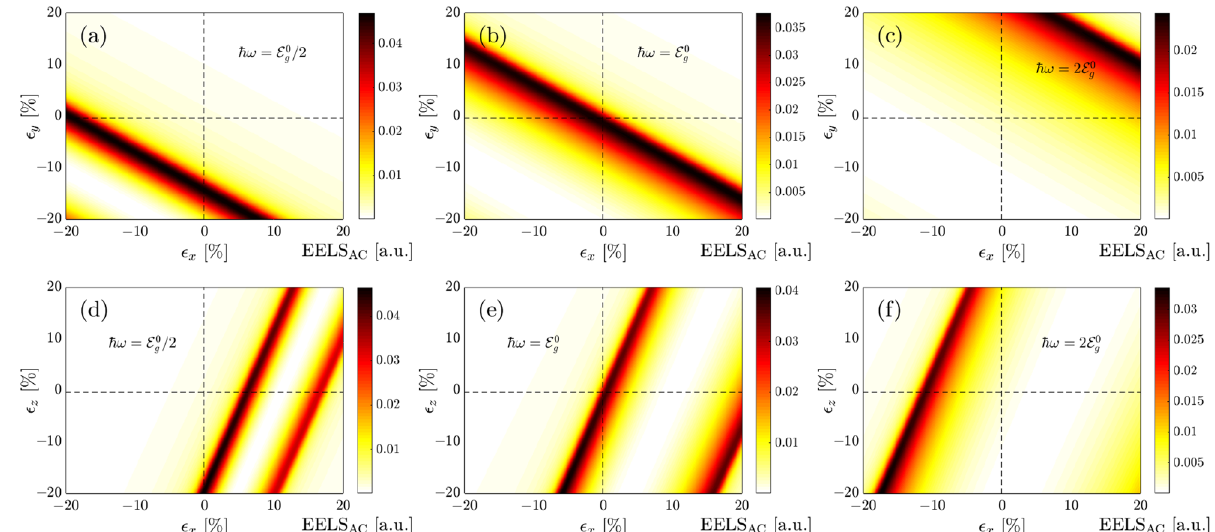
Figure 7. Low-energy interband part of the EELS in phosphorene along the AC direction for the combined effects of ǫ y and ǫ x at the optical energy ( a ) (cid:31) ω for the combined effects of ǫ z and ǫ x are presented in ( d – f